Question: Which visualization type does this figure use?
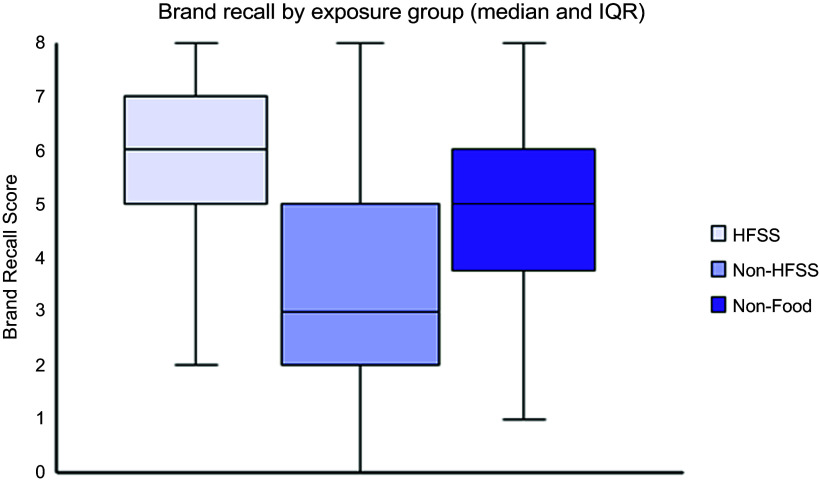
Answer: box